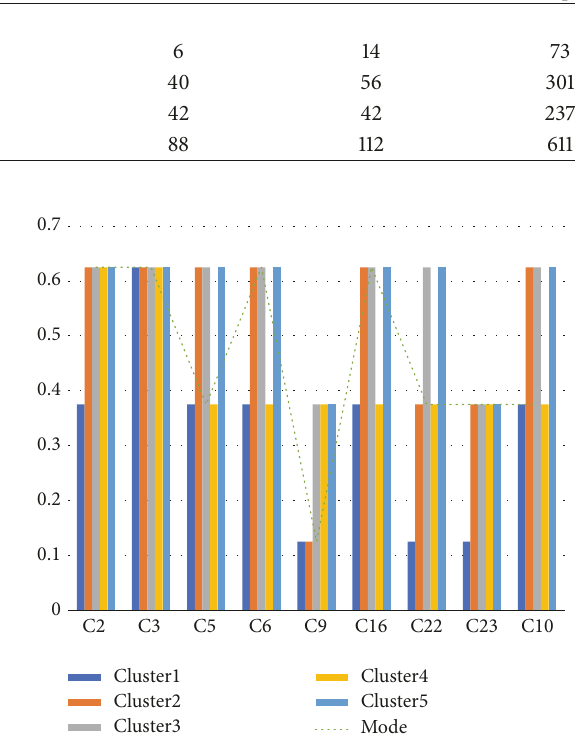
Figure 9: Project factors and clusters bar chart. Factor importance average score of each cluster plotted against the mode of the global